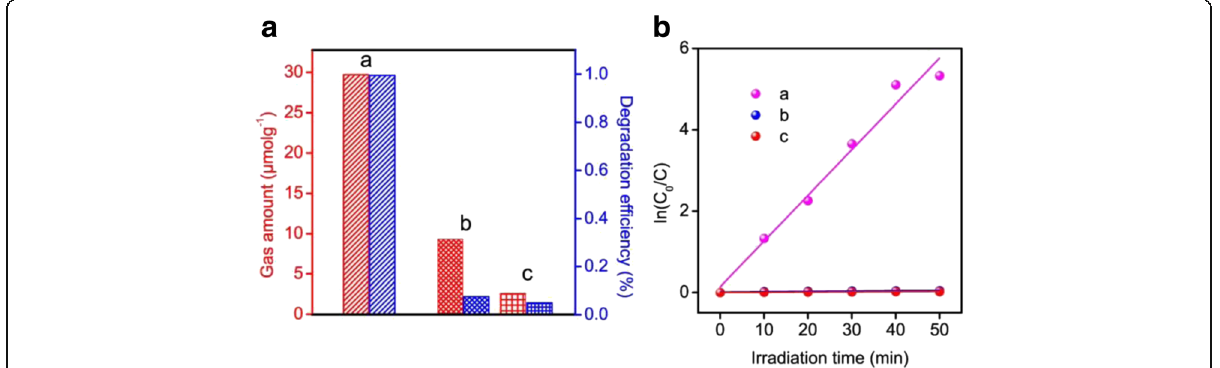
Fig. 5 Photocatalytic water splitting over the samples. a SnNb 2 O 6 , b the mixed phases of SnNb 2 O 6 and Sn 2 Nb 2 O 7 . c Sn 2 Nb 2 O 7 in initial 5 h and MO degradation in the presence of the prepared photocatalyts in 70 min under visible light irradiation ( a ), relationship between ln (C 0 /C) and irradiation time for the degradation of MO over all samples ( b